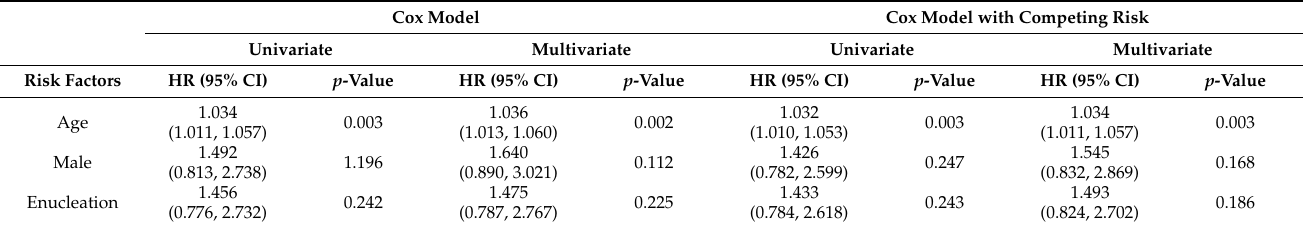
Table 4. Factors associated with the development of second primary